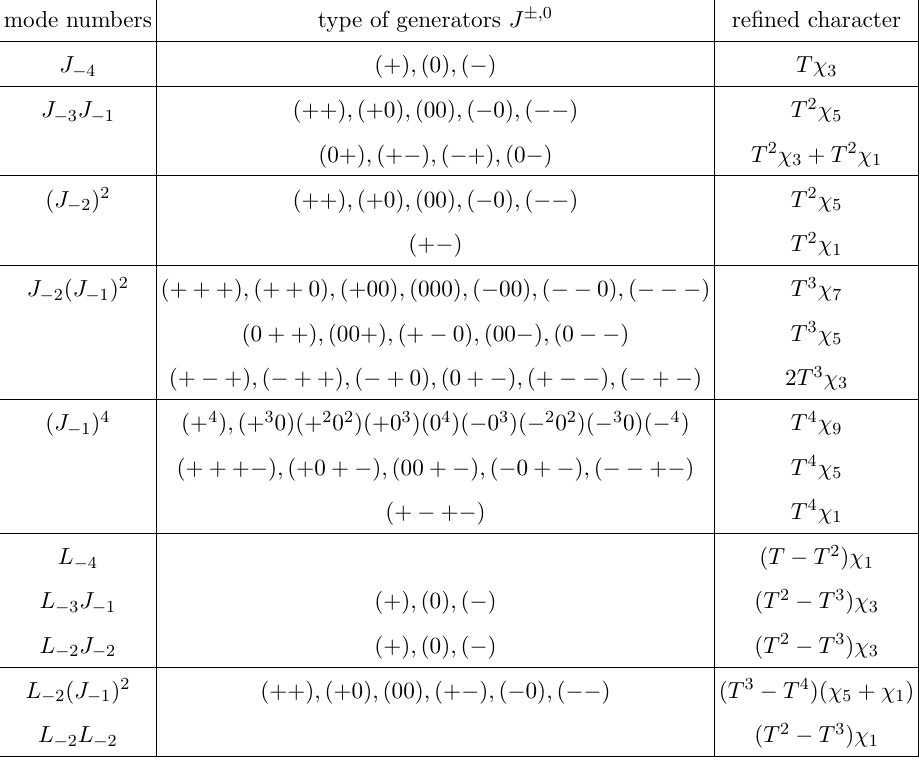
Table 2 . States of a generic vacuum module at level 4. The (cid:12)rst two columns of the table encode